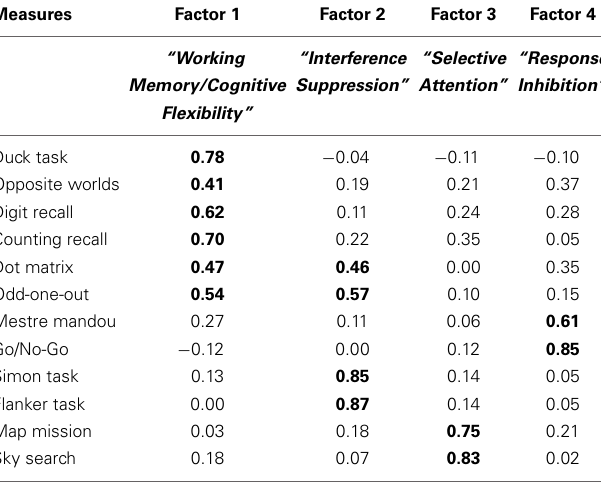
Table 5 | Factor loadings from principal component